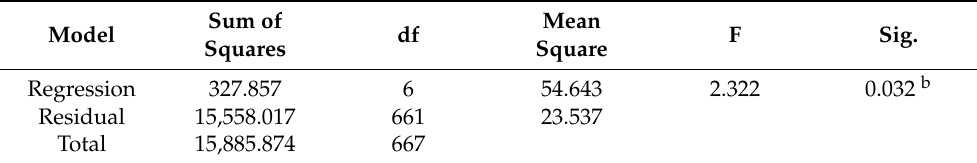
Table 5. Predictors for symptoms of stress using ANOVA a test. Mean Sum of F Sig. df Model Square Squares Regression 1416.461 6 236.077 6.029 0.000 b Residual 25,884.749 661 39.160 Total 27,301.210 667